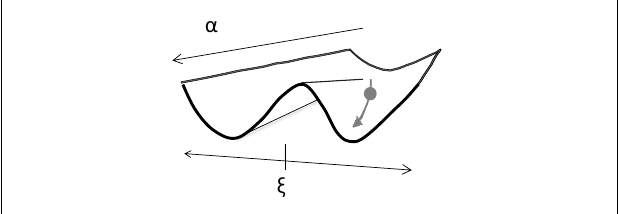
FIGURE 3 | Potential landscape and ball as symbol for the system’s state in context of synergetics ( α : control parameter, ξ : order